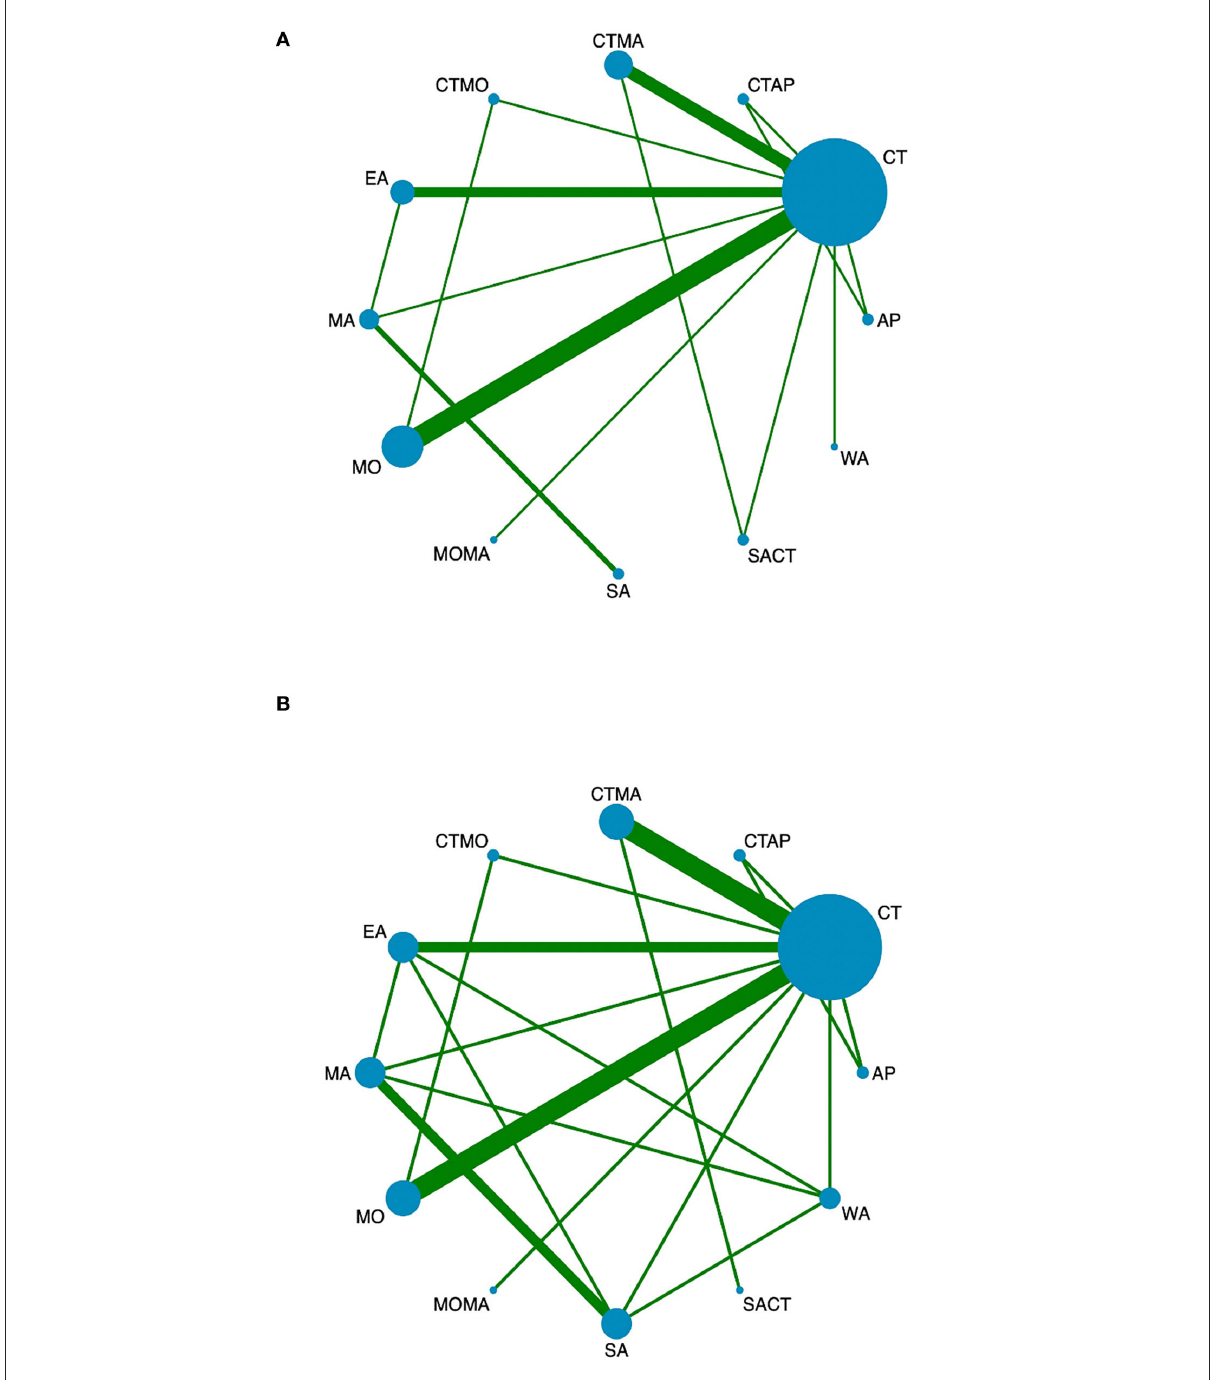
FIGURE3 Network diagrams of comparisons of different outcomes of treatments in patients with MCI. (A) Network meta-analysis of multiple acupuncture-related treatments for MMSE. (B) Network meta-analysis of multiple acupuncture-related treatments for MoCA. Each node represents an intervention and the size of each node represents the number of randomly assigned participants. Each line represents a direct comparison between interventions and the width of the lines represents the number of studies. MMSE, mini-mental state examination; MoCA, montreal cognitive